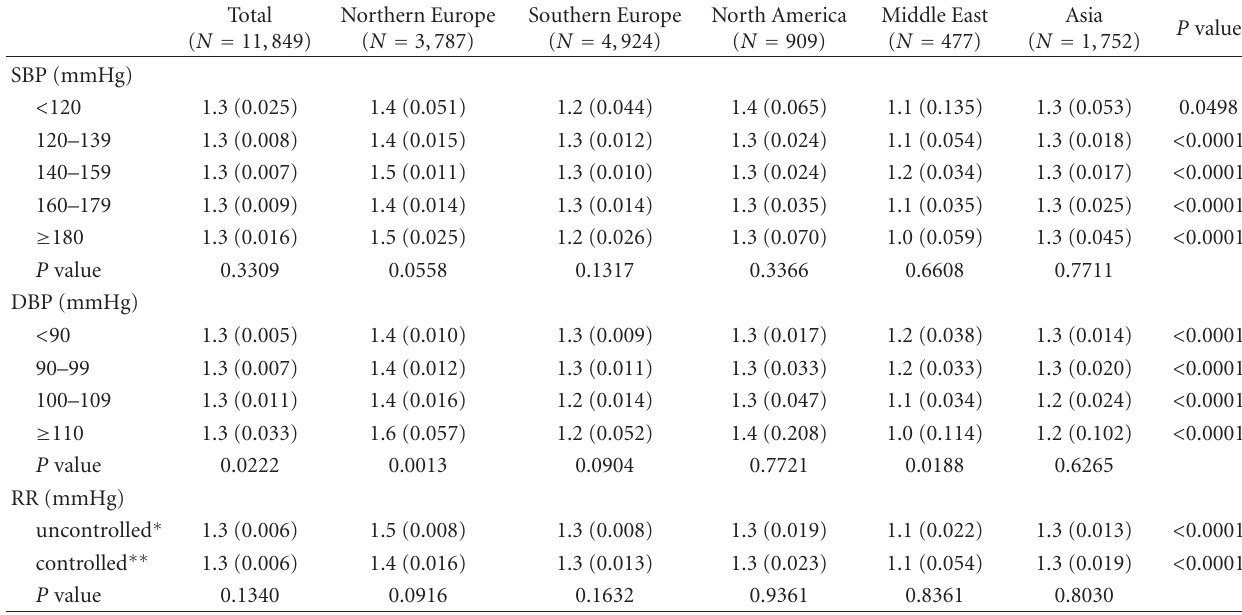
Table 7: Blood pressure and HDL-Cholesterol (mmol/L ± SD, adjusted for age, gender, and